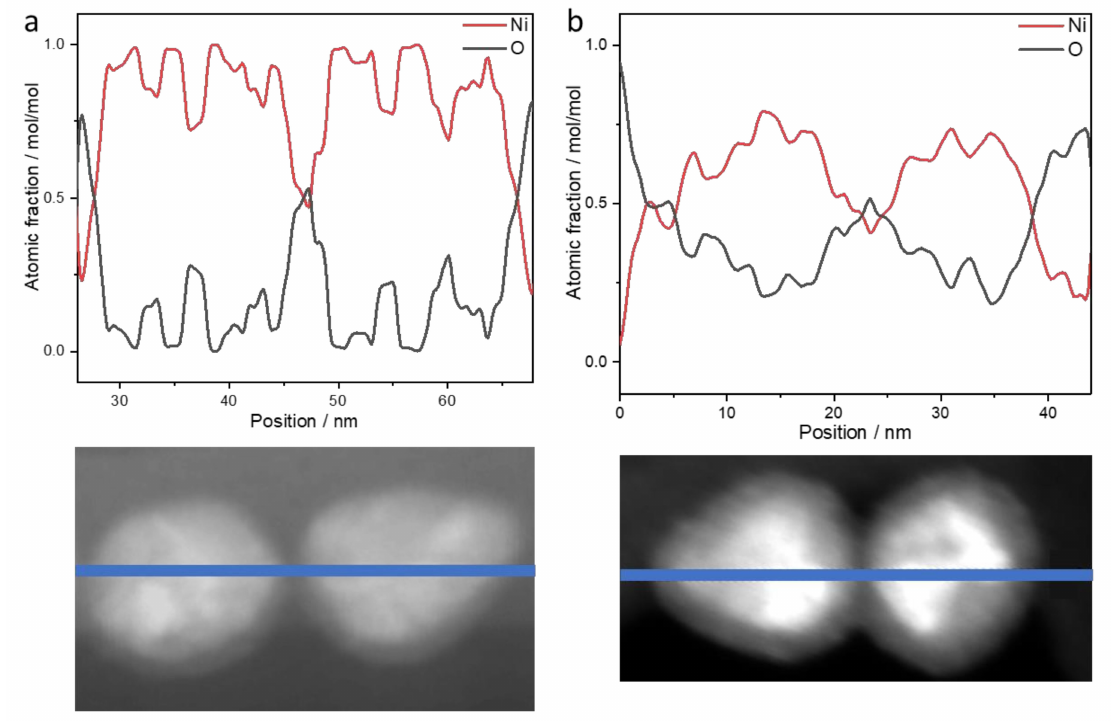
Figure 6. Element distribution of nickel and oxygen by EDS / STEM on the nanoparticles: ( a ) Two weeks after preparation; ( b ) stored in air for nine weeks after first measurement. The full STEM image and the regions of interest are shown in Figure S5.